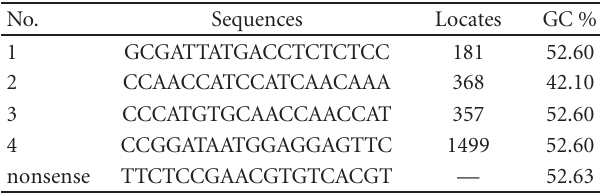
Table 1: Information of four designed shRNA and nonsense